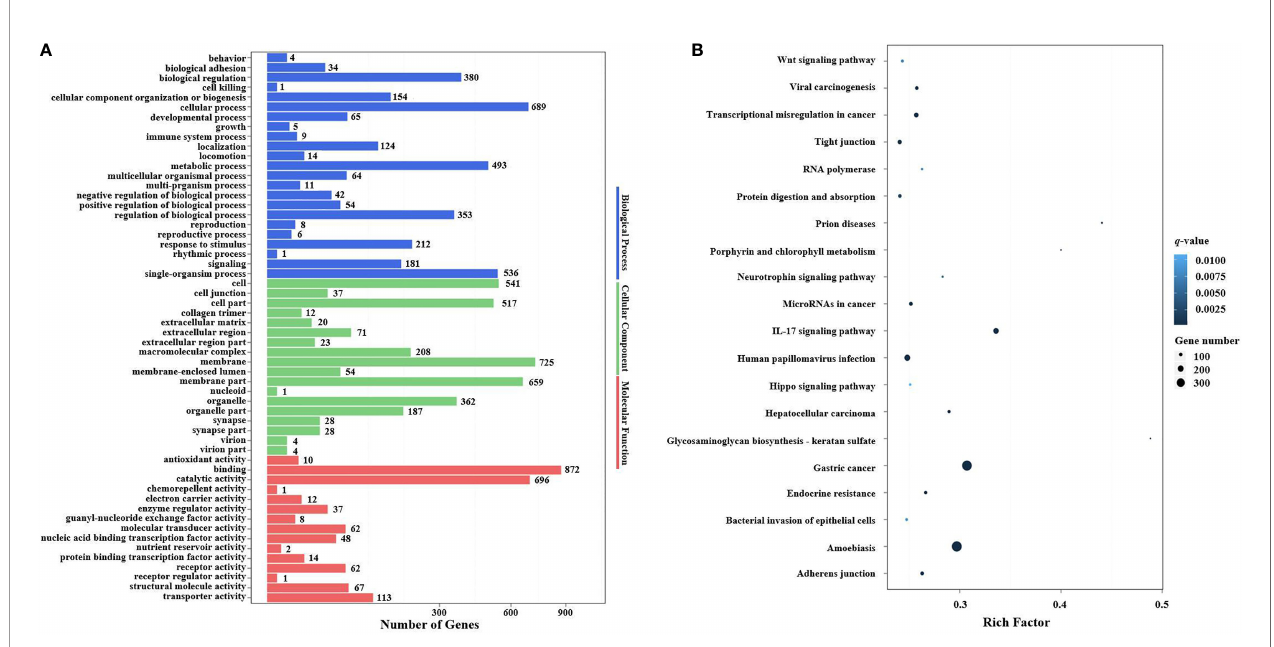
FIGURE 6 | GO terms and KEGG pathway enrichment analyses of target genes of DEMs. (A) GO term enrichment analysis of target genes of DEMs. Three main GO categories: biological process, cellular component, and molecular function. The x-axis indicates the number of genes, and the y-axis indicates the GO terms (level 2). (B) Top 20 KEGG pathways enriched in target genes of DEMs (level 3). The x-axis indicates the ratio of the number of genes in the DEGs, and the y-axis indicates the pathways. GO, Gene Ontology; KEGG, Kyoto Encyclopedia of Genes and Genomes; DEMs, differentially expressed miRNAs; DEGs, differentially expressed